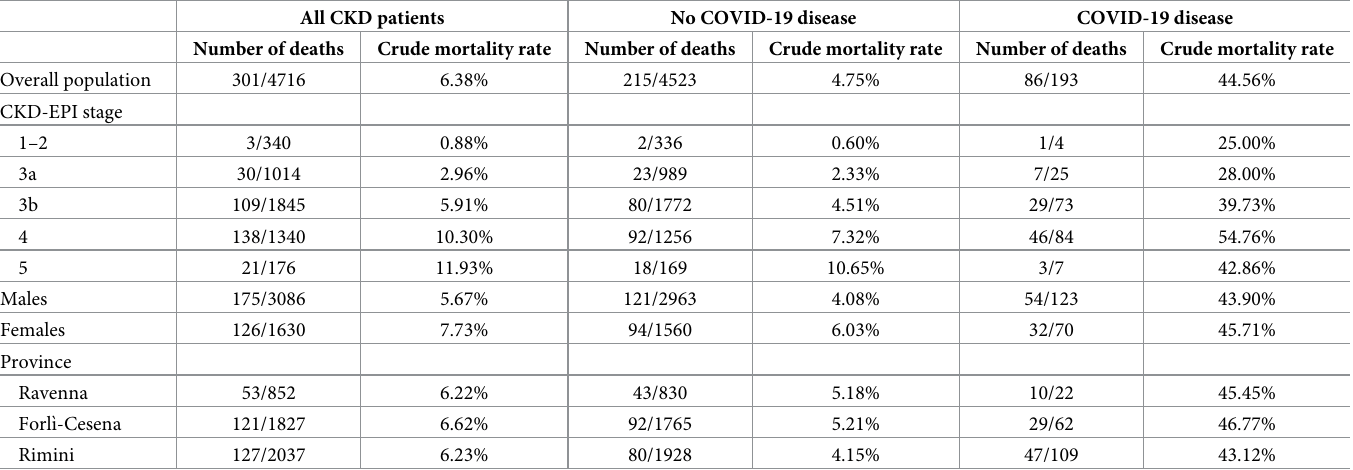
Table 2. Mortality in CKD patients with and without COVID-19